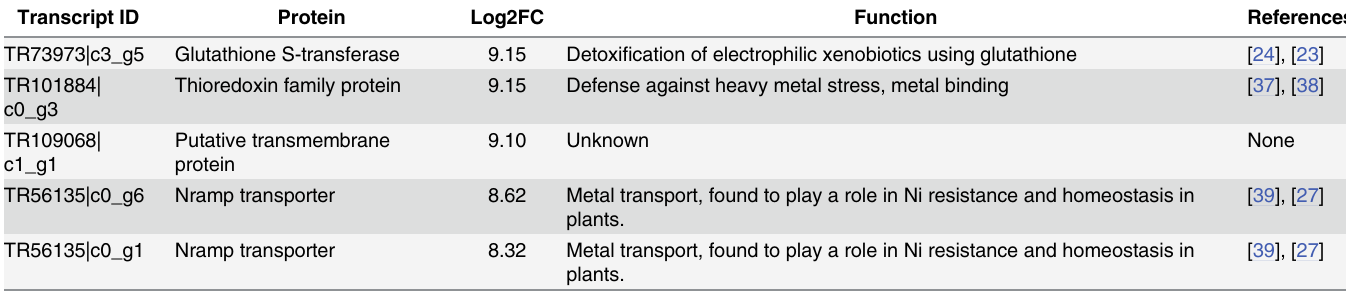
Table 1. Candidate genes involved in nickel resistance of white birch ( Betula papyrifera ).